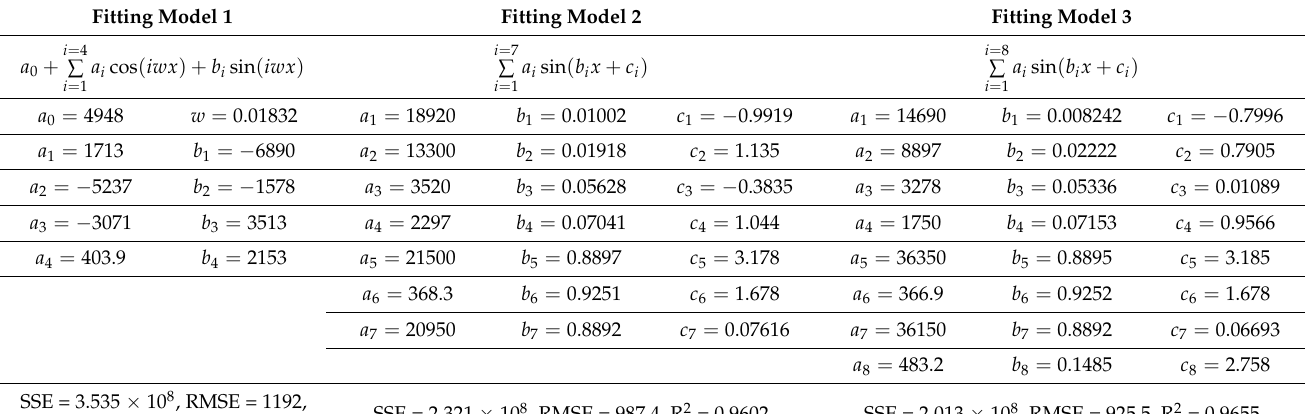
Table 6. Used mathematical fitting models for Germany data with optimized